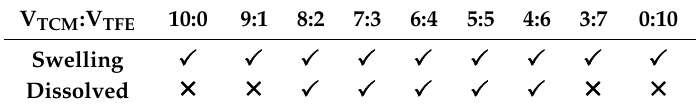
Table 1. Solubility of TPU (5% w / v ) in TCM/TFE solvent system at different solvent ratios.